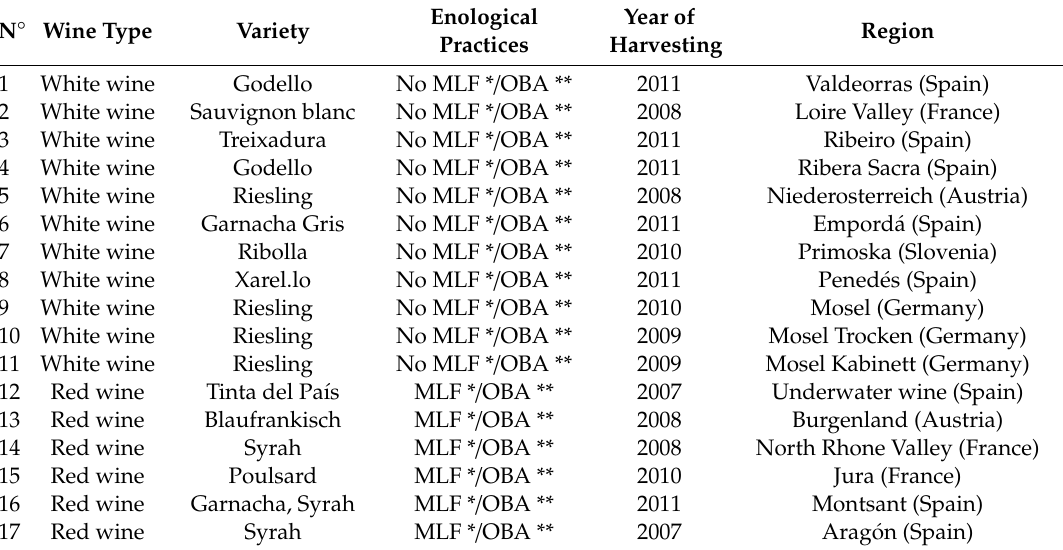
Table 1. Identification of the samples of white and red wine used in the